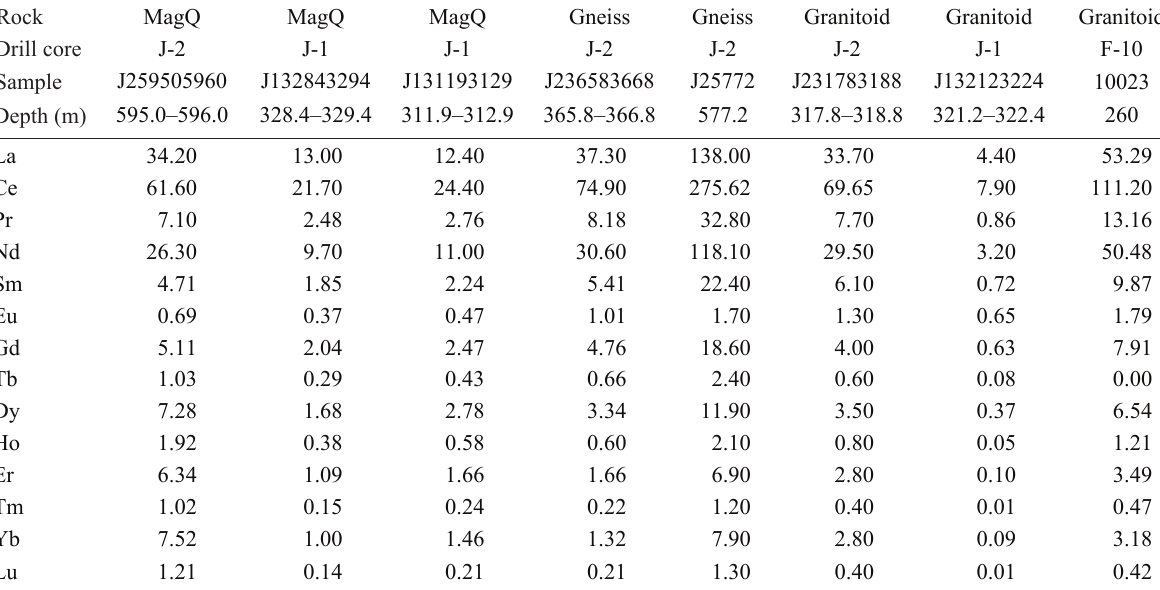
Table 2. Selected ICP­MS rare earth element analyses in the Jõhvi magnetite quartzites (MagQ) and surrounding granitoids and gneisses. Full set of analyses at https://doi.org/10.23679/506